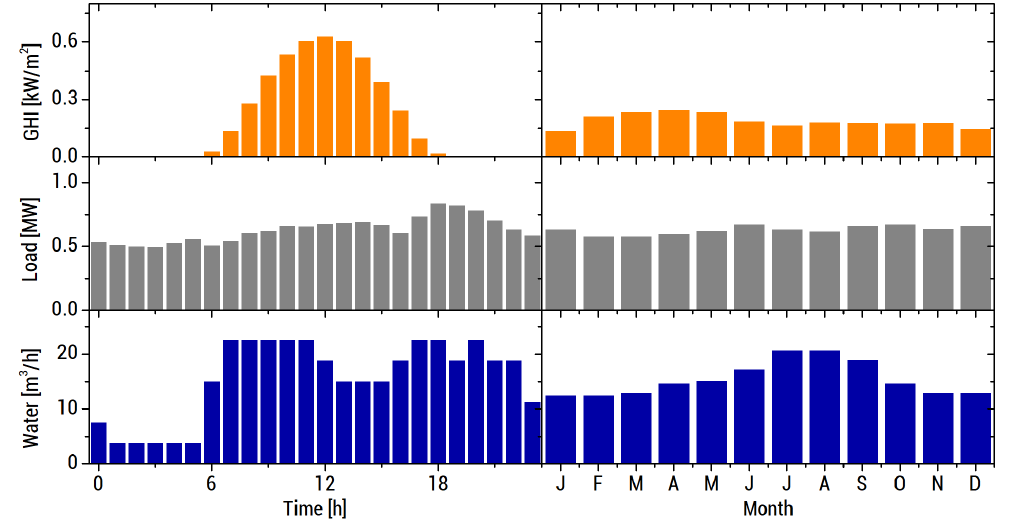
Figure A5. Daily and monthly average electric, water, and GHI profiles on Lubang Island.